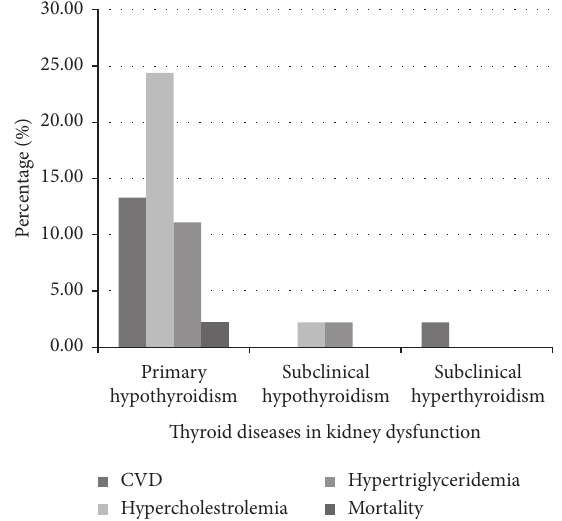
Figure 9: Distribution of various outcomes in thyroid-kidney disease. Dark gray column with three plus sign shows frequency of mortality in hypothyroidism patients, dark gray column with two plus sign is indicative of frequency of cardiovascular disease (CVD) in primary hypothyroidism and subclinical hyperthyroidism, dark gray column with one plus sign is indicative of hyper- triglyceridemia in primary hypothyroidism, and light dark column shows hypercholesterolemia in hypothyroidism